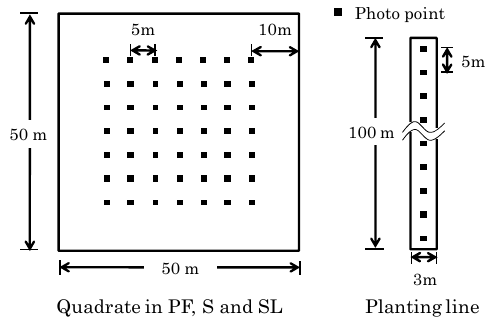
Figure 3. Hemispherical photography setting in the quadrate at the PF, S and SL sites and the planting line transect.